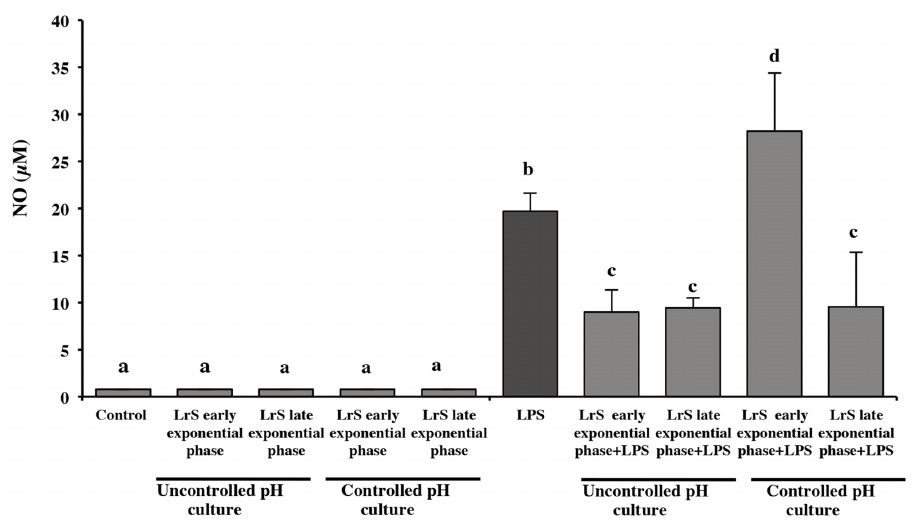
Fig 4. Effect of LrS obtained in RPMI medium on NO production by RAW 264.7 macrophages. RAW 264.7 cells were challenged with LPS and LrS obtained from bacteria grow in PETG medium in early and late exponential phase, at controlled and uncontrolled pH conditions. Cells with a without LPS challenge were used as control. NO production was measured in culture supernatants by Griess assay. Data shown are a representative result of three independent experiments. Values not sharing the same letter were significantly different (p-value < 0.05).